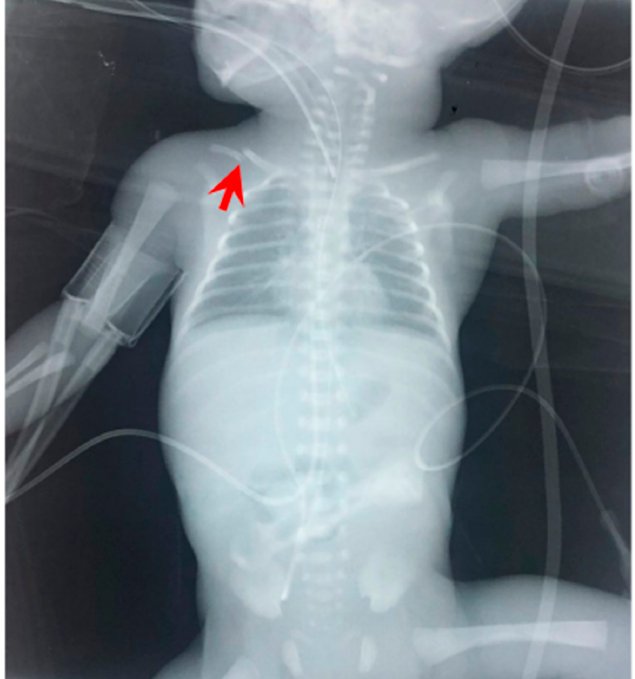
Figure 3. Radiography of the neonate on the day of deterioration. Non-specific signal characteristics in the abdomen, such as distention and poor distribution of bowel gas. A clavicular fracture clavicle is noted on the right (red arrowhead). is noted on the right (red